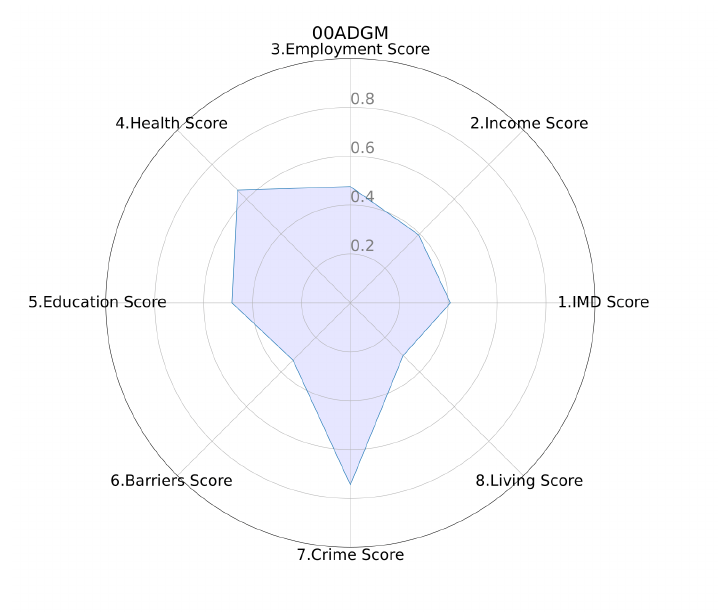
Figure 1. Radar graphic representing every MinMax normalized